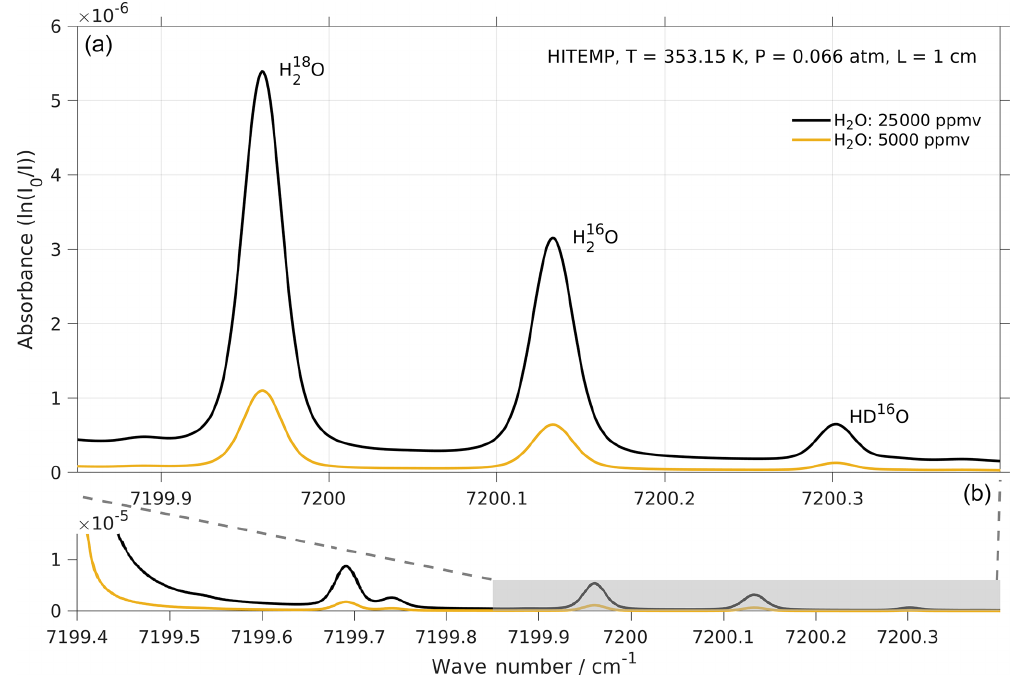
Figure 5. Absorption spectrum of H 18 O, H 16 O, and HD 16 O in the frequency range targeted by the laser of Picarro models L2130-i and 2 2 L2140-i. Simulations with two water concentrations, i.e. 25000 (black line) and 5000ppmv (orange line), were performed by using http: //spectraplot.com (last access: 19 February 2020) with the HITRAN–HITEMP database (Goldenstein et al., 2017). Simulation parameters are set according to the cavity conditions of the Picarro analyser as follows: T = 80 ◦ C, P = 50Torr, and L = 1cm. Panel (a) is an enlarged version of the shaded area in panel (b)